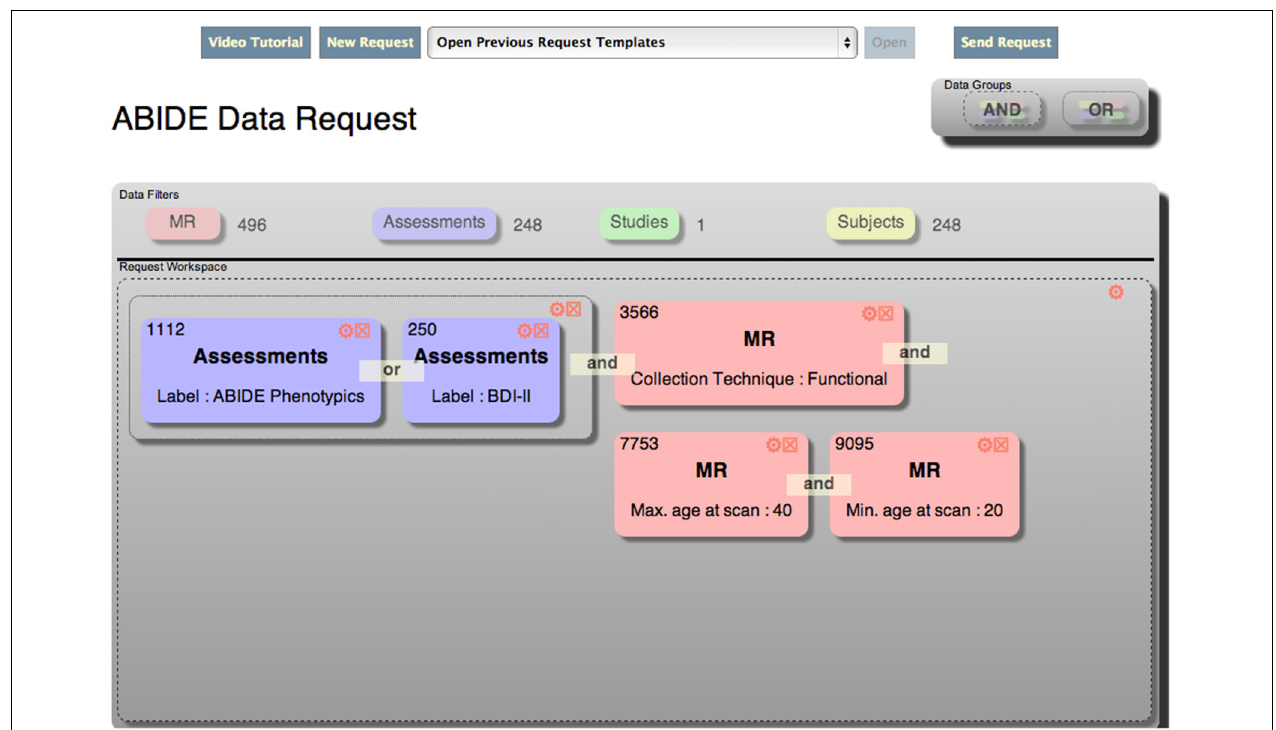
FIGURE 1 | DX data catalog exploratory filtering